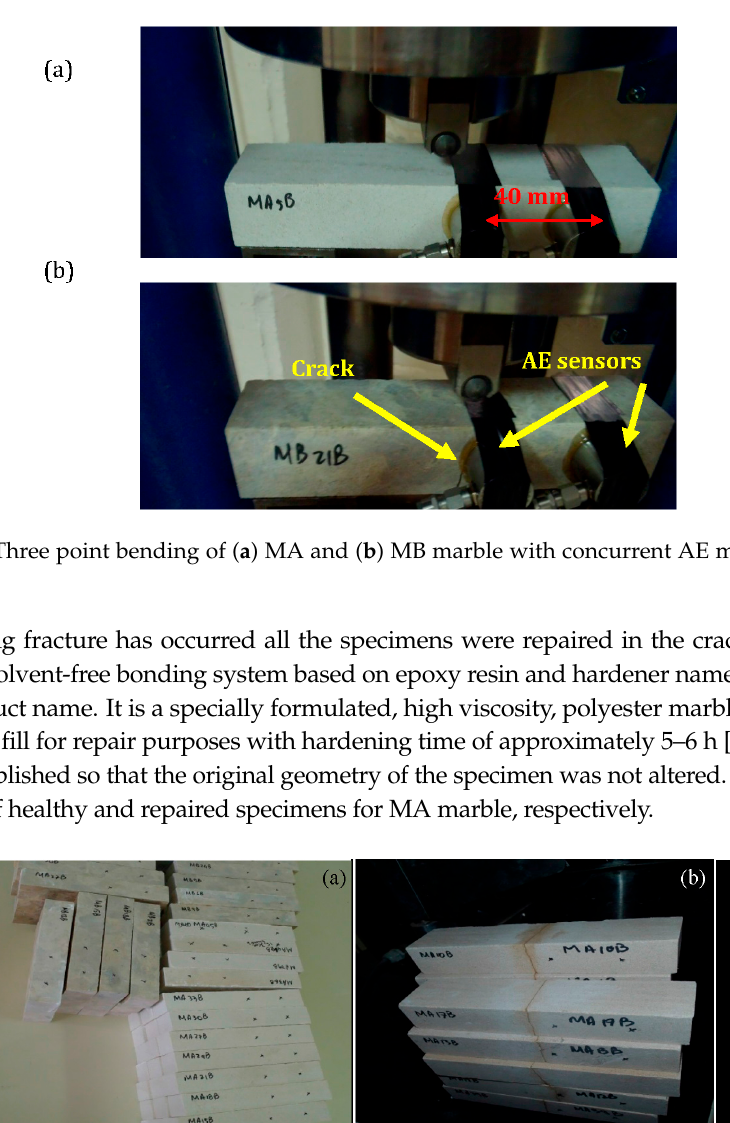
Figure 3. The population of ( a ) healthy and ( b ) repaired specimens for MA marble.